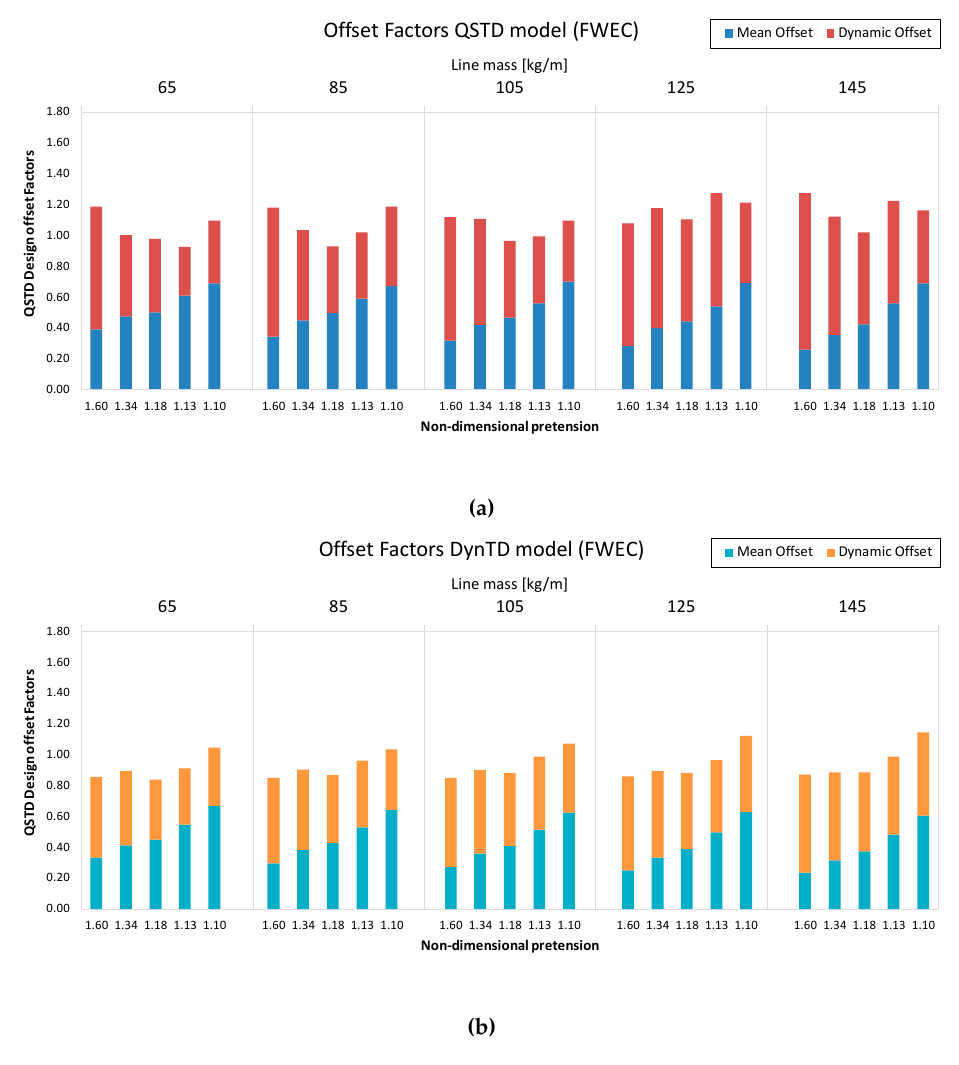
Figure 6. Surge factors with respect to QSFD model of the QSTD (a) and DynTD (b) approaches. Accumulated bars with the weights of the mean and dynamic offsets.